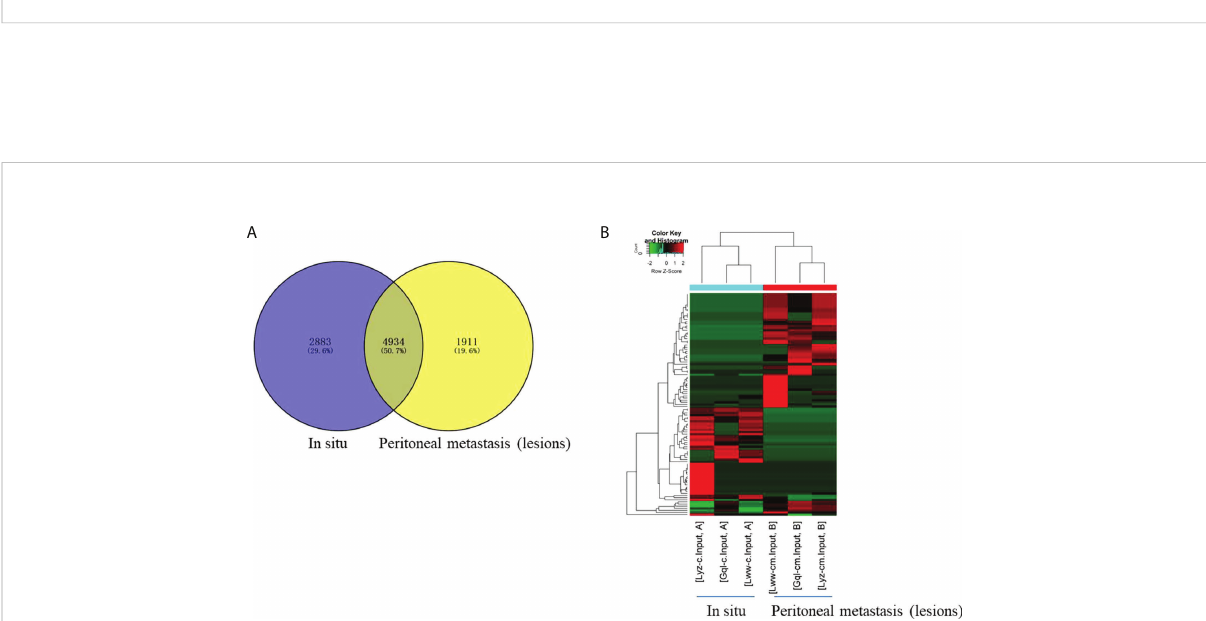
FIGURE 2 The differentially expressed circRNAs between the in situ and the peritoneal metastasis lesions of the HGSCO patients. (A) Vnn diagram and (B) Heatmap presenting the differential expressed circRNAs between the in situ and the peritoneal metastasis lesions of the HGSCO